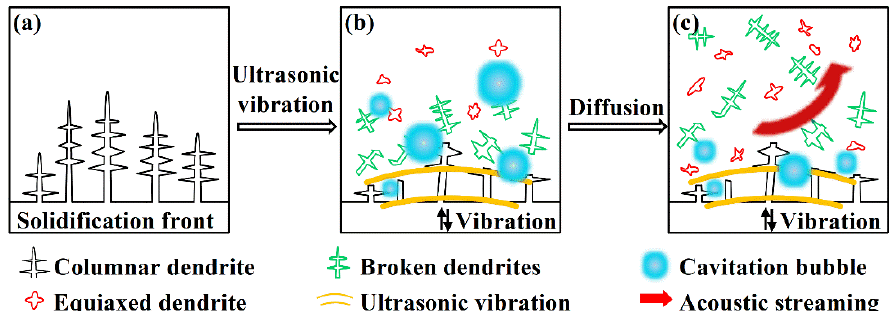
Figure 7. Mechanism of ultrasonic vibration in the solidification crystallization process. ( a ) crystal- lization process of unassisted coating; ( b ) cavitation bubble collapse and dendrite fracture process under ultrasound; ( c ) heterogeneous nucleation transited by acoustic streaming.